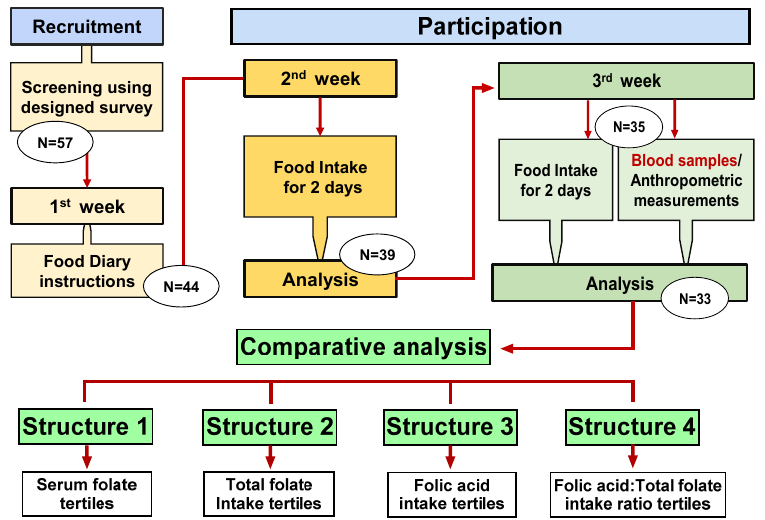
Figure 2. Study design schematic. Fifty-seven healthy adults aged (18–40) were recruited for the study. Participants were initially screened, followed by food diary collection, analysis, and screening, additional food intake analysis, blood sampling, and collection of data. Data analysis was performed using 4 comparison structures based on: serum folates tertiles (structure 1), total folate intake tertiles (structure 2), folic acid intake tertiles (structure 3), and folic acid/total folate intake ratio tertiles (structure 4).